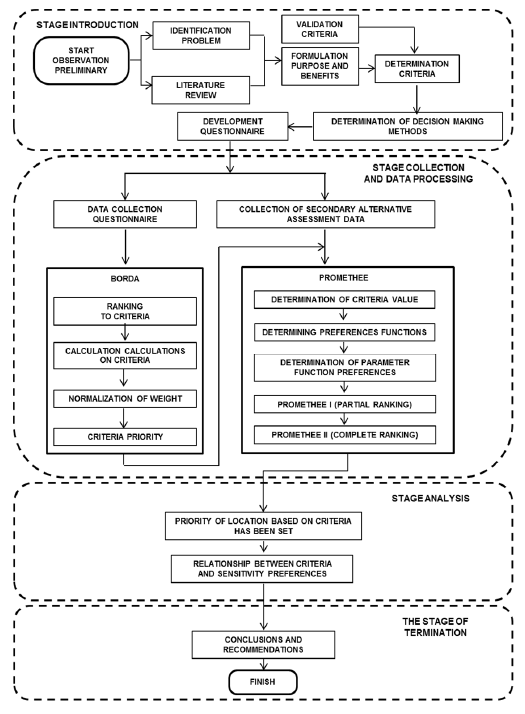
Fig. 1. Flowchart of